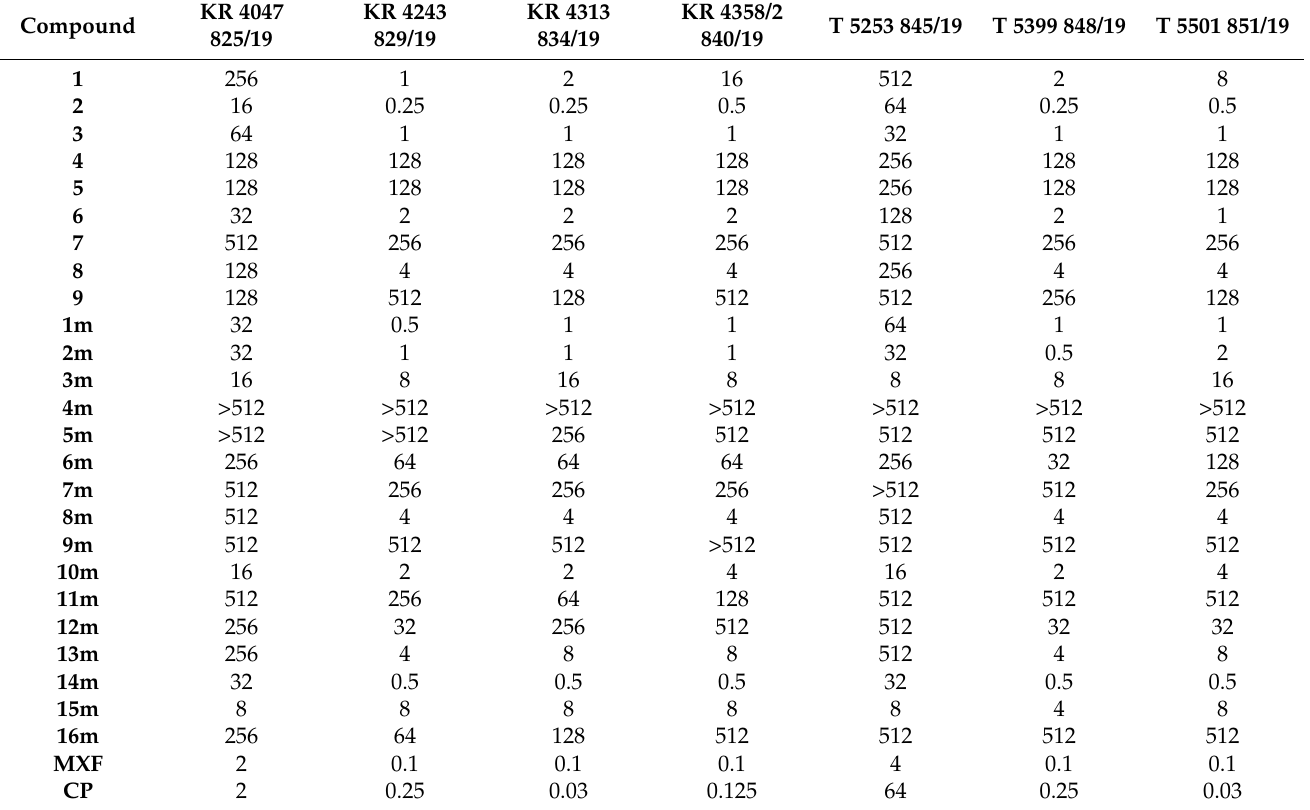
Table 3. Activities of CP ( 1 – 9 ) and MXF ( 1m – 16m ) conjugates against clinical S. epidermidis strains after 18 h of treatment-minimal inhibitory concentrations (MIC, µ